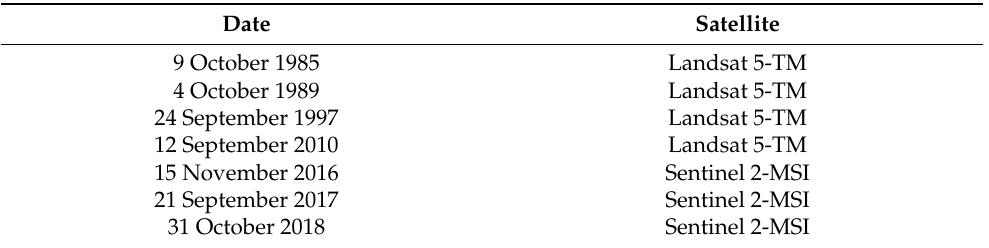
Table 1. Dates and satellite source of the processed satellite images. The Landsat-5 images have a spatial resolution of 30 m, the Sentinel-2 images have a spatial resolution of 10 m.